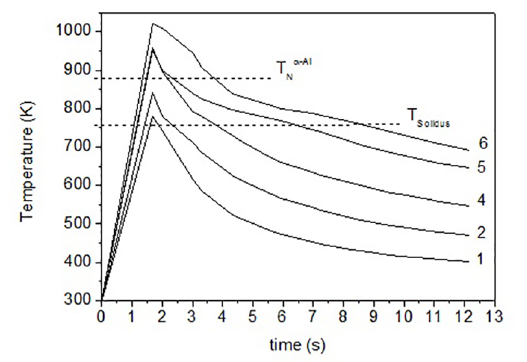
Figure 4. Cooling curves of Al-5Si3Cu alloy solidified in six-stepped cylindrical steel mold recorded by the thermocouples 1,2 4, 5 and 6. Where Tα-AlN is equal to 880 K and T